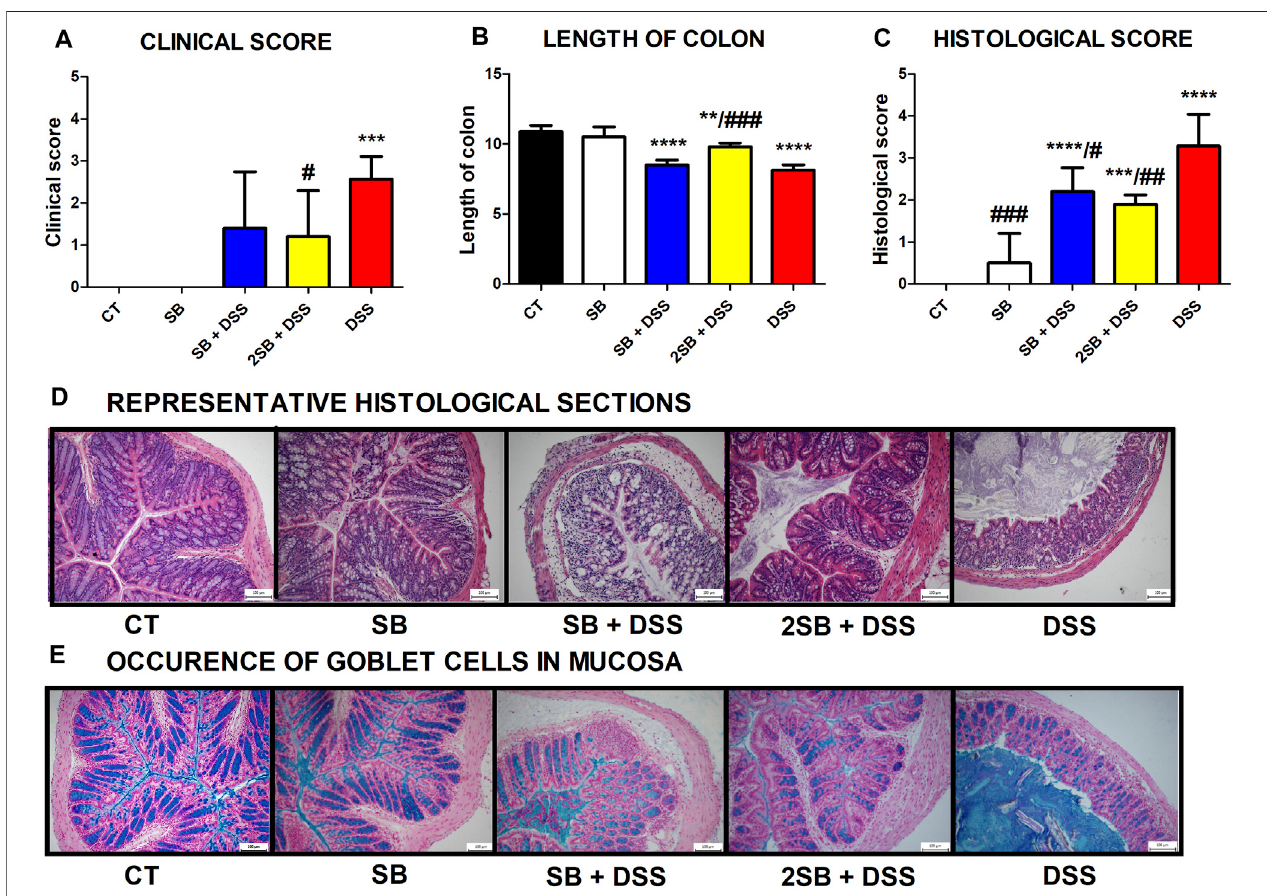
FIGURE 1 | Impact of butyrate pre-treatment on clinical symptoms and histopathological changes in the dextran sodium sulfate mouse model of ulcerative colitis. Altogether 25 mice were equally separated into fi ve groups according to sodium butyrate (SB) and DSS treatment. (A) Occurrence of diarrhea and rectal bleeding was summarizedintheclinicalscore. (B) Shorteningofcolonlengthand (C) histopathologicalchangesincolonicmucosaafterDSStreatmentsummarizedasthehistological score was analyzed at the end of experiment. Changes in colonic mucosa after DSS-treatment are shown on representative histological sections stained by hematoxylin/eosin. (D) Occurrence of goblet cells in mucosa of representative colon sections was visualized by Alcian blue/nuclear fast red staining. Data in graphs are expressed as mean ± SD and represent one out of two experiments. One-way ANOVA with Tukey ’ s multiple post hoc test was used for comparison of experimental groups to CT controls (group 1: * p < 0.05, *** p < 0.001, **** p < 0.0001) or to DSS-controls (group 5: Y p < 0.05, YY p < 0.001, YYYY p < 0.0001). CT : drinking water; SB : 0.5% sodium butyrate in drinking water for 2 weeks; SB + DSS : 0.5% sodium butyrate in drinking water 1 week before and the next week together with 2.5% DSS in drinking water; 2SB + DSS : 0.5% sodium butyrate in drinking water 2 weeks before 2.5% DSS in drinking water; DSS : 1 week 2.5% DSS in drinking water.